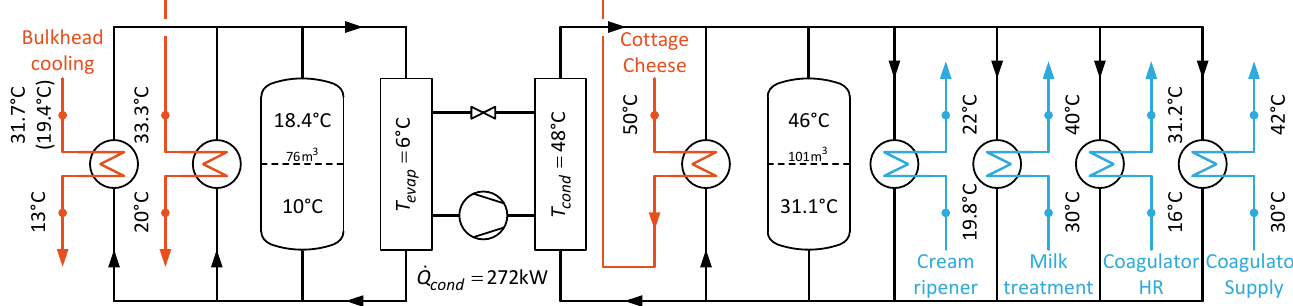
Figure 17. Schematic of solution Variant 2: Combined IHR and HP